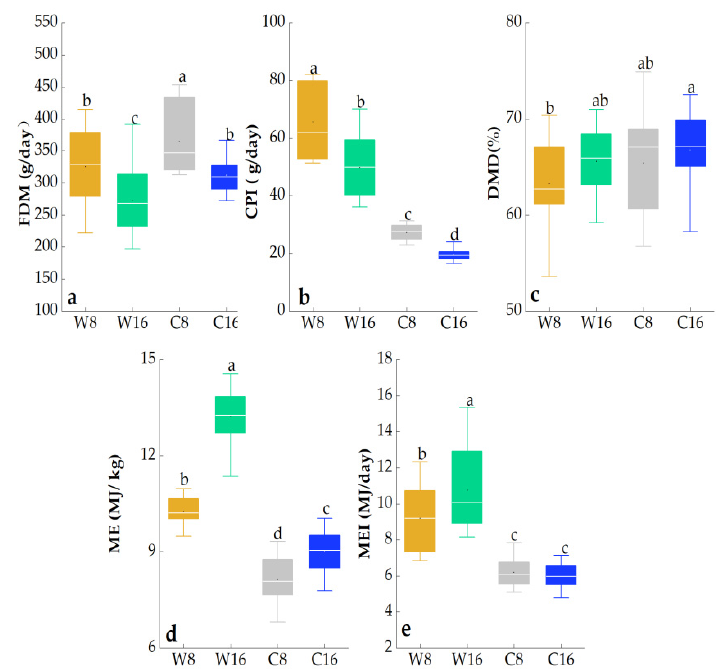
Figure 3. E ff ects of grazing seasons (warm and cold) and stocking rates (8 sheep / ha and 16 sheep / ha) on mean ( ± SE) digestive and metabolic indicators in two years (2010 and 2011). Means within Figure 3. Effects of grazing seasons (warm and cold) and stocking rates (8 sheep/ha and 16 a column with di ff erent letters significantly di ff er ( p < 0.05). Di ff erent lowercase letters indicate sheep/ha) on mean (± SE) digestive and metabolic indicators in two years (2010 and 2011). Means significant di ff within a column with different letters significantly differ ( p < 0.05). Different lowercase letters indicate significant differences.